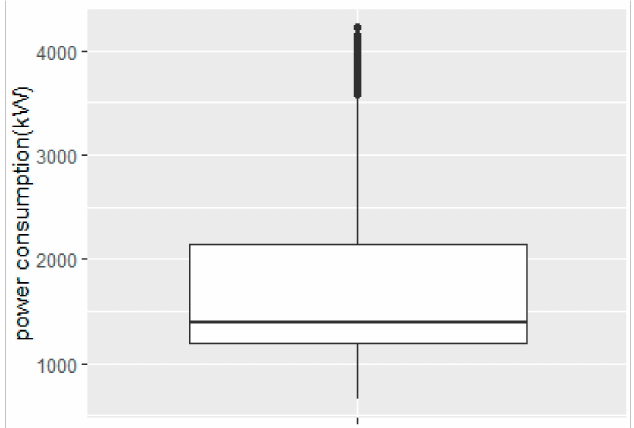
Figure 3. Boxplot after outliers were